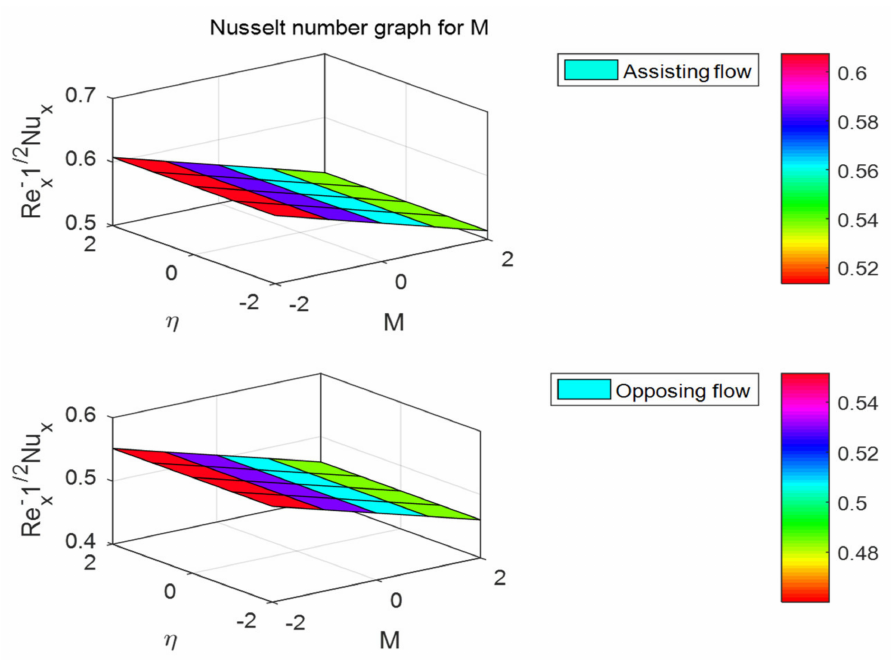
Figure 26. Surface plots of the θ (cid:48) ( 0 ) for dissimilar values of M .